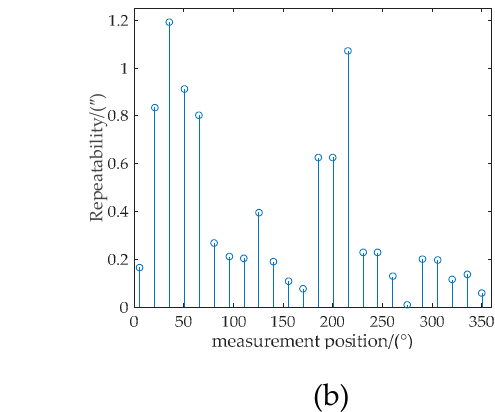
Table 5. Parameters of